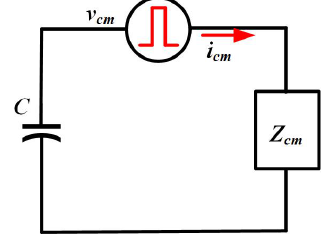
Figure 2. CM equivalent circuit of the motor drive.